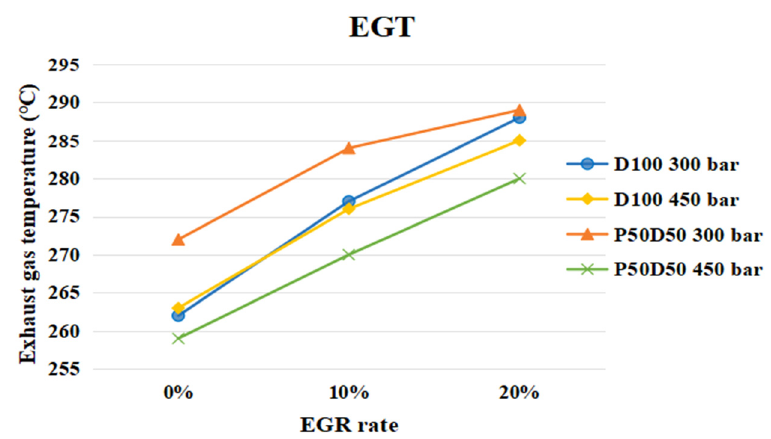
Figure 13. EGT under different EGR rates at 300 and 450 bar.